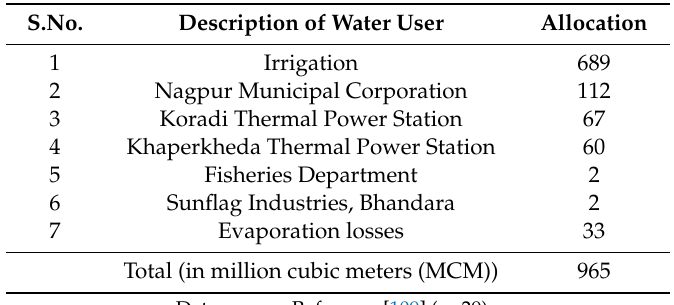
Table 2. Water ‐ allocation planning for the Pench Irrigation Project, 1996.